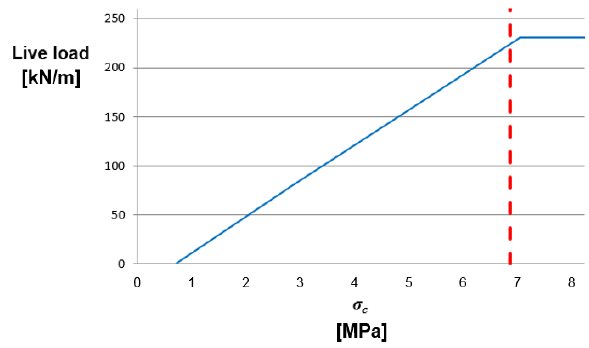
Figure 12: Porta Napoli bridge. Brittle hinges at the springings: Compressive stress vs live load.